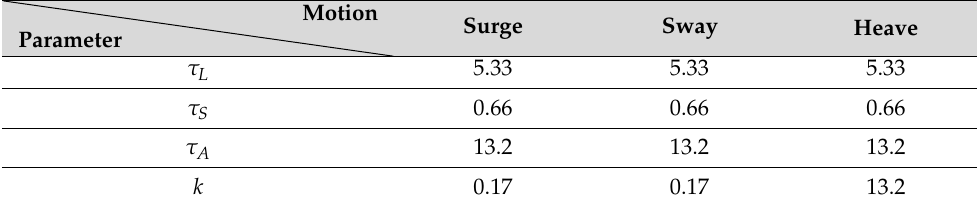
Table 2. Parameters of the otolith model.